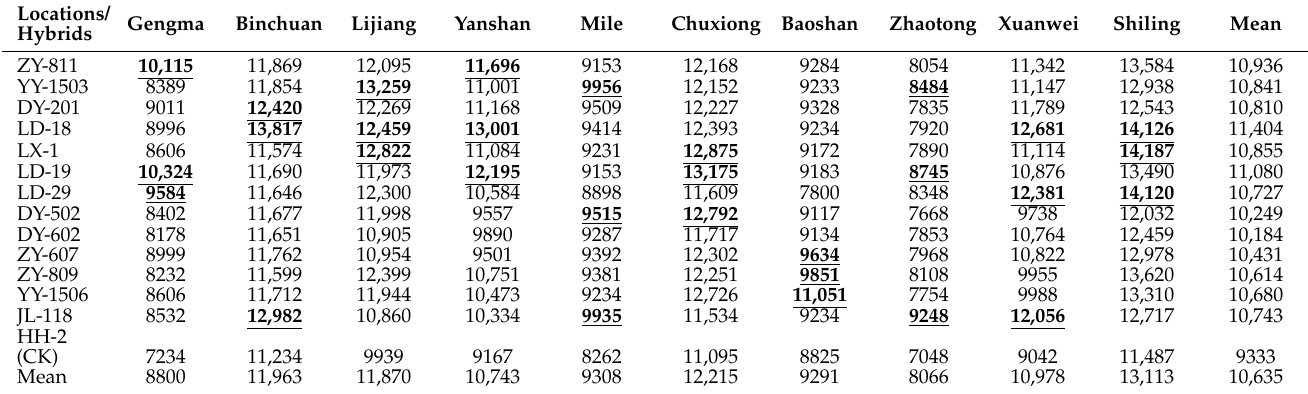
Table 6. Mean yield (kg ha − 1 ) of 14 maize hybrids across 10 environments in 2021.